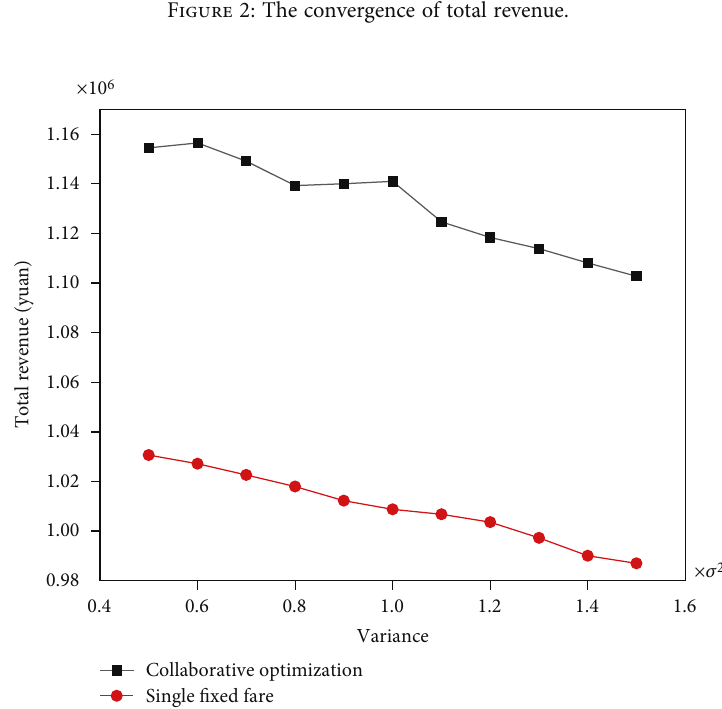
Figure 2: The convergence of total revenue.